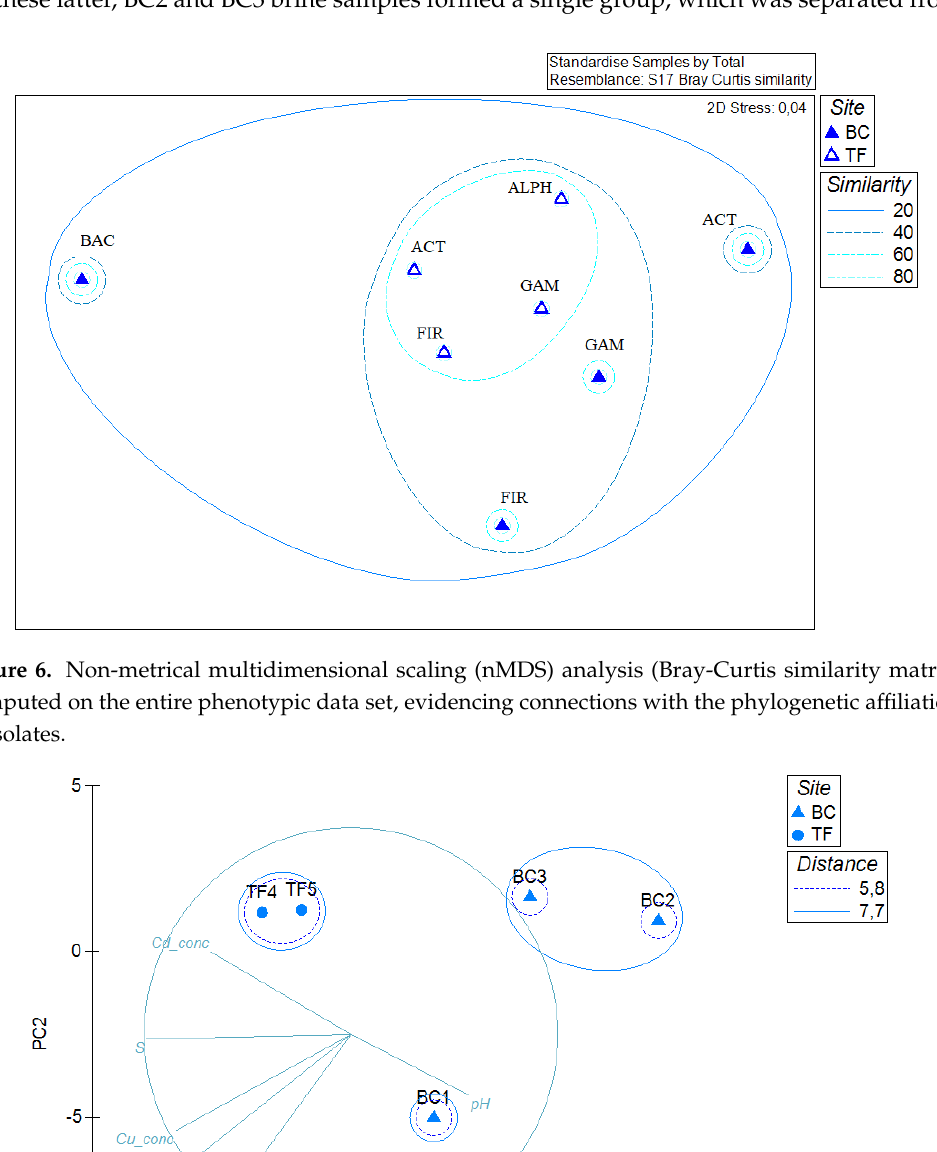
Figure 7. Principal component analysis computed on the entire phenotypic data set and environmental parameters, evidencing differences between brine samples.